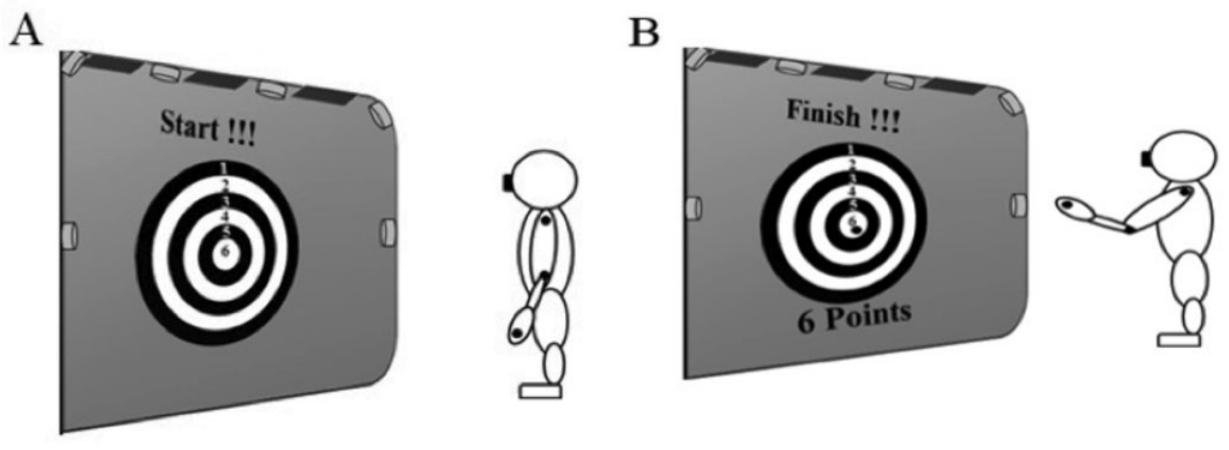
Figure 1. Task knowledge of results, (A) initial position, (B) final position.